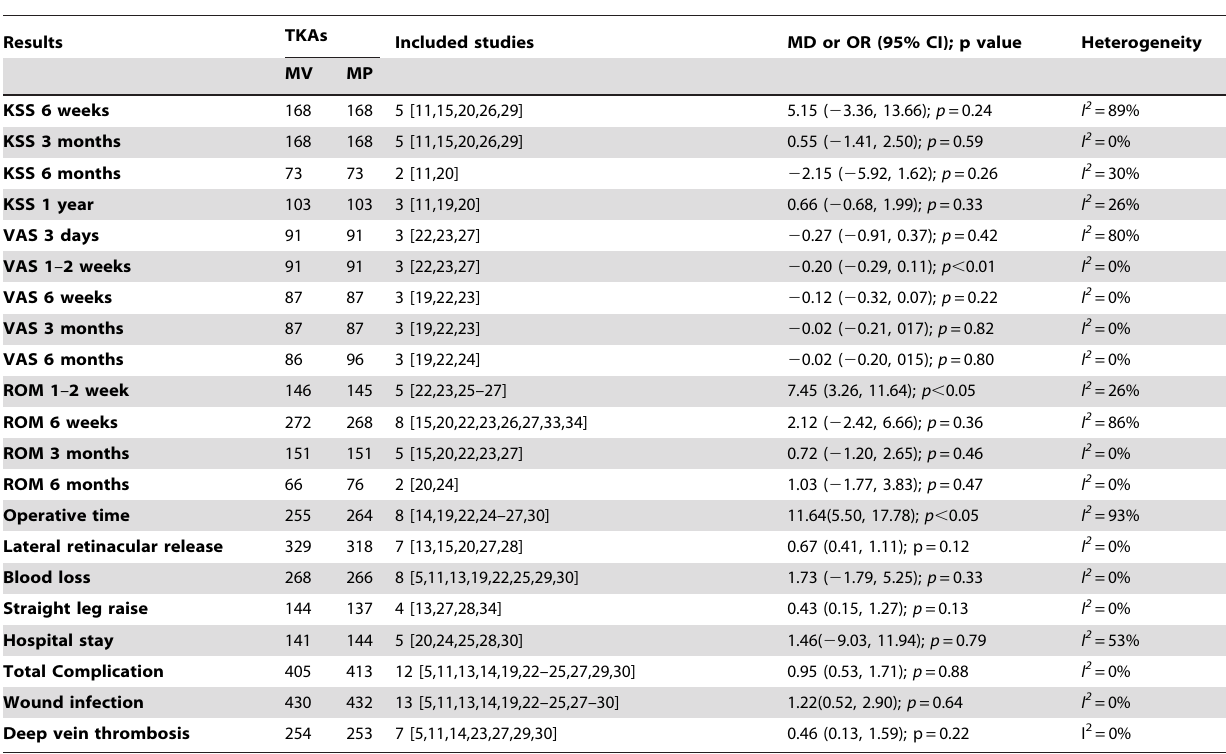
Table 3. Meta-analysis of nini-midvastus versus medial parapatellar